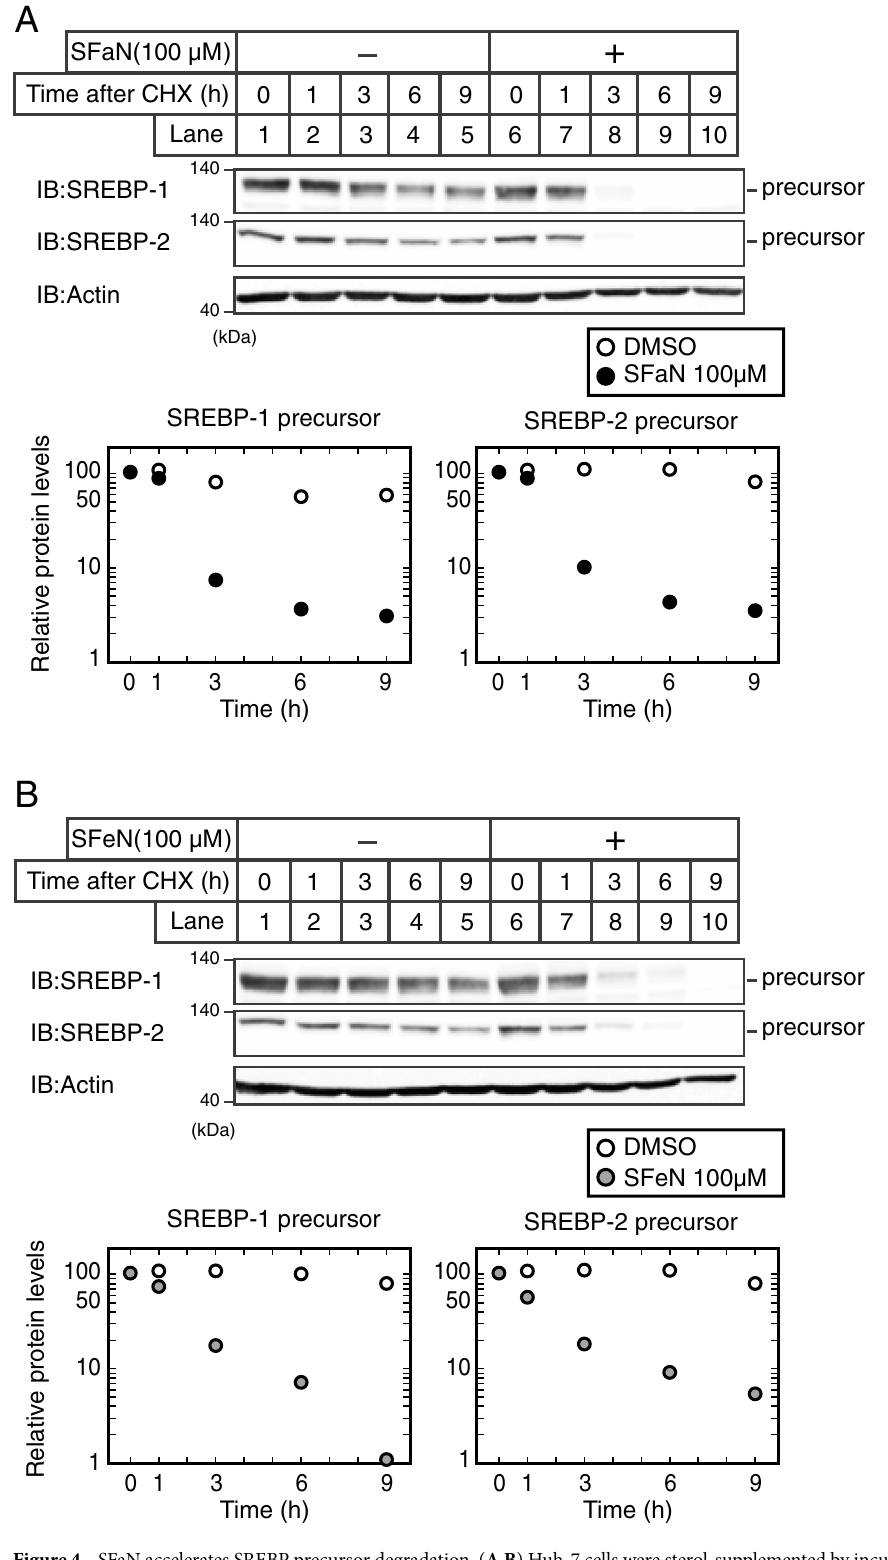
Figure 4. SFaN accelerates SREBP precursor degradation. ( A , B ) Huh-7 cells were sterol-supplemented by incubating in medium E for 16 h to increase the SREBP precursor forms. After incubation with 50 μM cycloheximide for 30 min, the cells were shifted into medium E supplemented with 50 μM cycloheximide in the presence of the vehicle, 100 μM SFaN ( A ), or SFeN ( B ). After incubation for the indicated periods, whole-cell extracts underwent immunoblotting (IB) with anti-SREBP-1 (2A4), anti-SREBP-2, or anti-β-actin antibodies. The signals were quantified by Image J and normalized by β-actin signals. Full-length images are presented in Supplementary Fig.